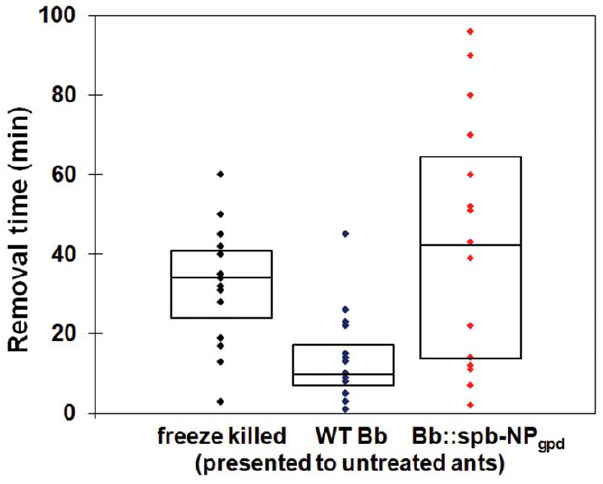
Figure 3. Responses of S.invicta to dead ants. Plots of the times between introduction and removal of items in the test arena. Boxes are bounded by the first quartile, median, and third quartile. Movement times of freeze-killed and fungal-killed, WT and Bb::sp b -NP gpd , ants presented to untreated ants. WT-killed ants were moved significantly more quickly than either freeze-killed or Bb::sp b -NP gpd -killed ants (P=0.0014).